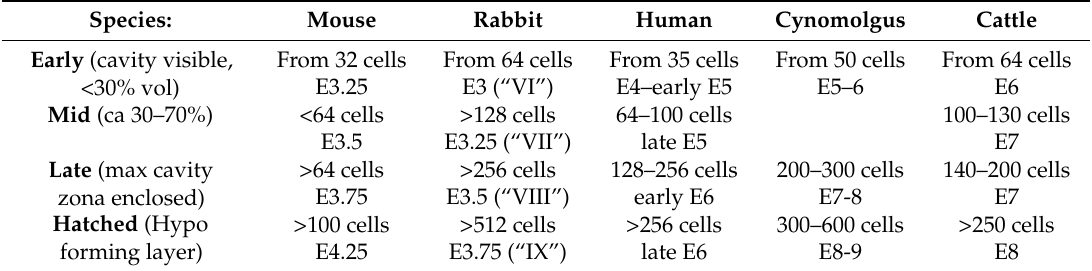
Table 2. Characteristics of early to hatched blastocyst stages in mammals 1